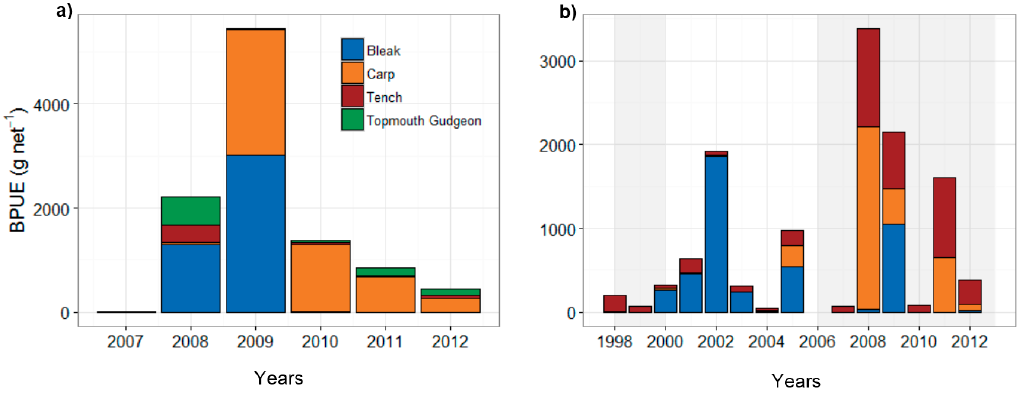
Figure 4. Biomass of the dominant fish species (g ∙ net − 1 ) in ( a ) Lake Mogan and ( b ) Lake Eymir (shaded periods indicating the first and second biomanipulation). Note the scale differences on the y and x ‐ axes.